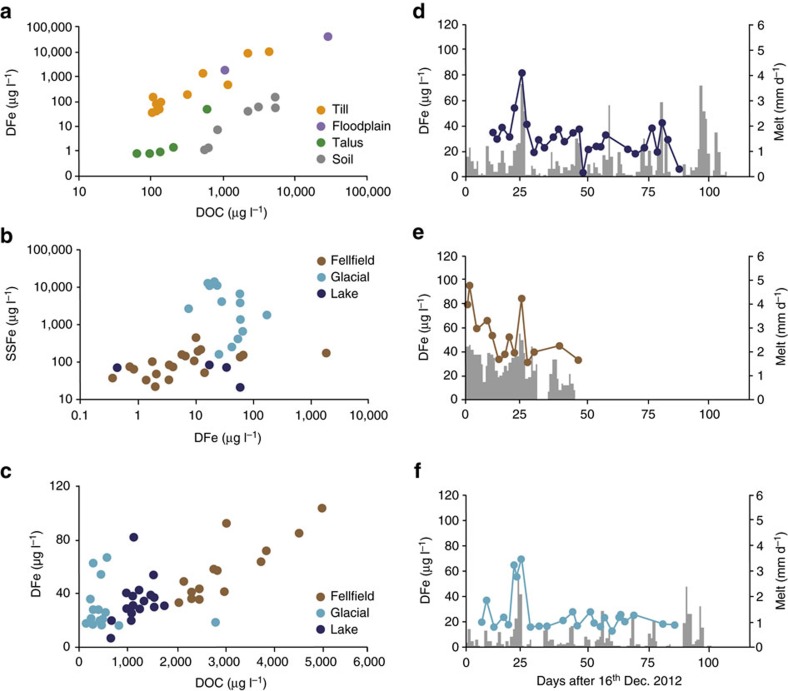
DFe relationships with key parameters and seasonal DFe dynamics.Data points in a and b represent individual spring and stream sites, respectively (averaged in the case of multiple samples). Data points in c–f represent individual samples collected upon Signy Island. Colour-coding in a distinguishes different sedimentary environments, whilst in b–f, colours represent different catchment land cover characteristics (fellfield: brown; glacierized: light blue and lake-influenced: dark blue). Figures (d–f) also show daily melt variations in the lake-influenced, fellfield and glacial catchments upon Signy Island, respectively, to help depict seasonal changes.